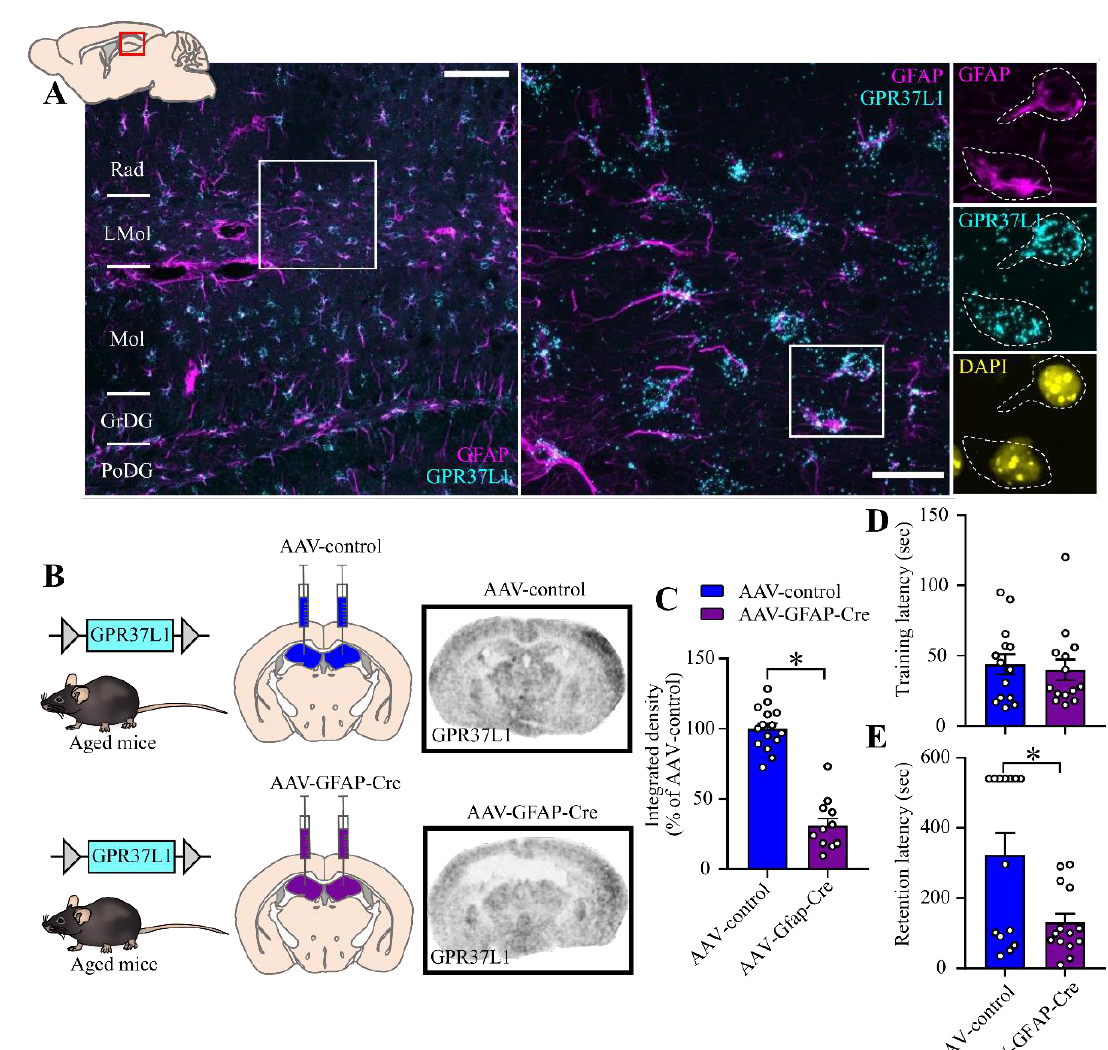
Figure 4. Effect of hippocampal GPR37L1 in the passive avoidance task (PAT) in hippocampal astrocyte-specific GPR37L1KD mice versus controls. Combined fluorescent ISH (RNAscope) and immunofluorescence showing the expression of GPR37L1 in GFAP-positive cells in dorsal hippocampus (( A ), left scale bar: 100 µm, right scale bar: 30 µm). ISH confirmed the knockdown of the GPR37L1 gene in the hippocampus ( B ), quantification of GPR37L1 mRNA levels in the dorsal hippocampus ( C ), passive avoidance test for the mice that have been injected with AAV-control and AAV-Gfap-Cre, training phase of the passive avoidance task ( D ) and the retention phase of the passive avoidance task ( E ), n = 14 – 16/group. Statistical analysis was carried out using Student’s t -test. * p < 0.05. Results are expressed as Mean ± SEM. Rad: radial layer, LMol: lacunosum moleculare layer, Mol: molecular layer, GrDG: granular layer of dentate gyrus, PoDG: polymorph layer of dentate gyrus.